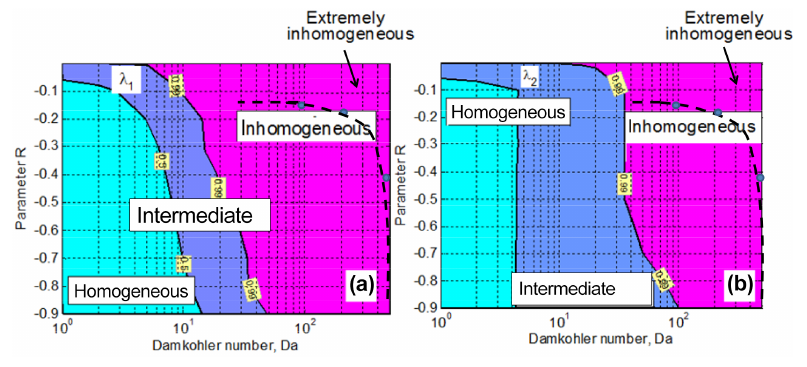
; (b) the boundaries T tot (cid:104) e q(T mix ) (cid:105)− 1 (Eq. 41). Dashed lines indicate the line R